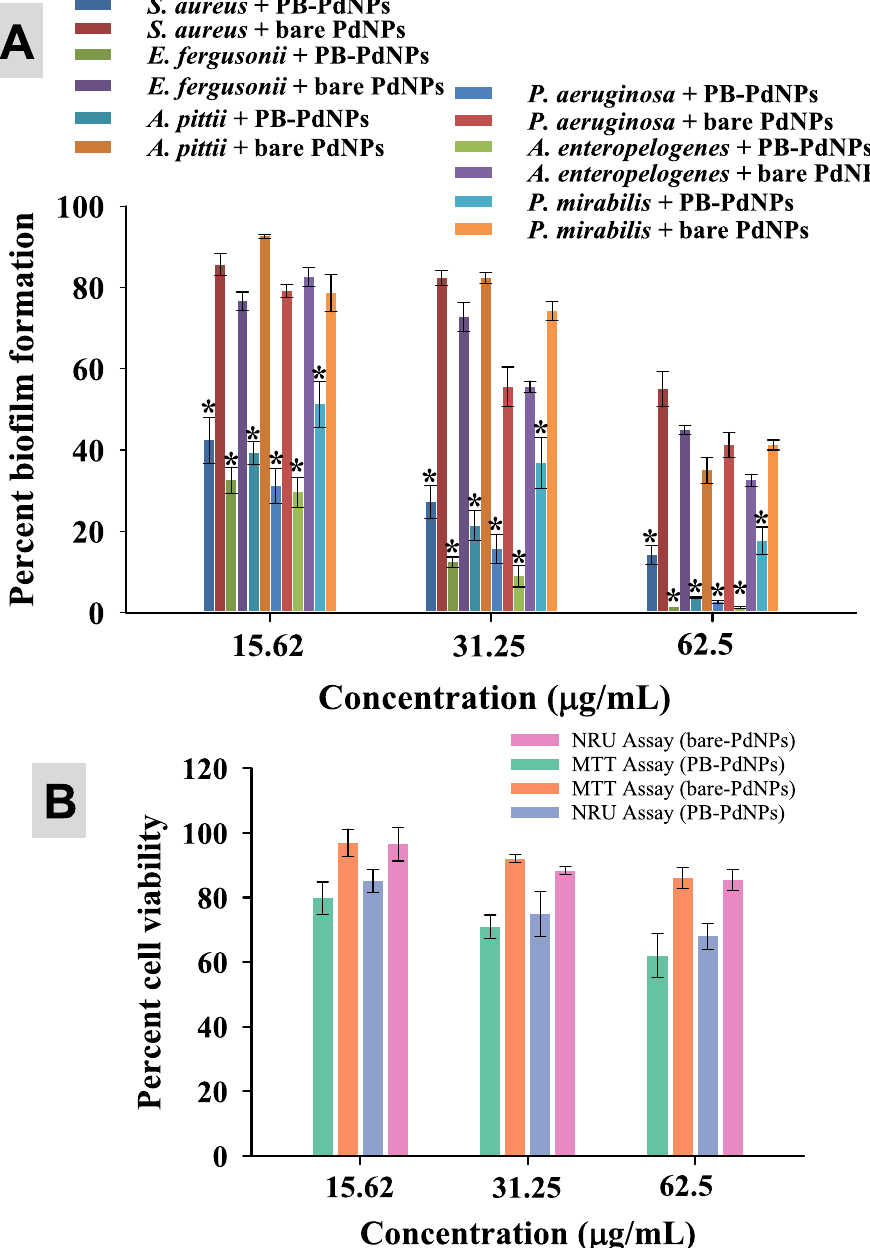
Figure 11. Comparison between the inhibiting potential of PB extract capped-PdNPs and bare surface Pd-NPs: Antibiofilm activity against six pathogenic strains (panel A) and viability of MCF-7 cells (panel B). Data represents mean values of three independent replicates and error bars represent standard deviation (S.D.). * P ≤ 0.05 as calculated by student’s